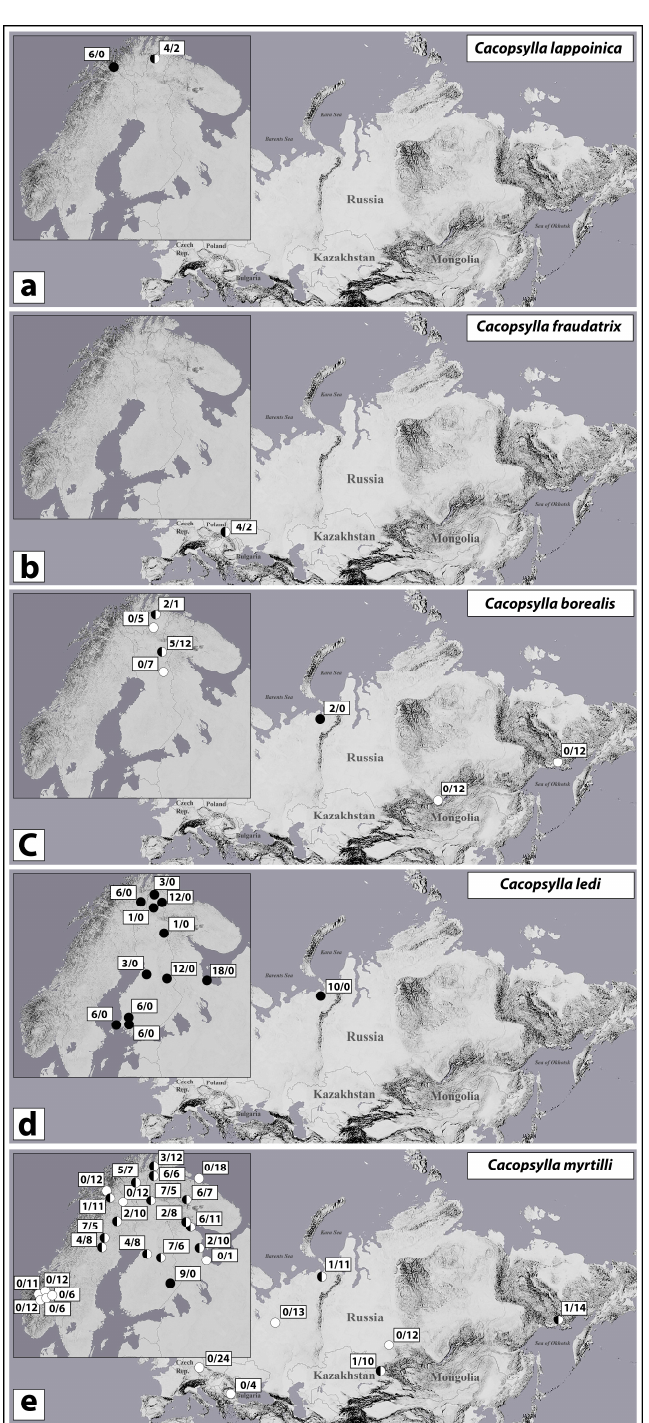
Figure 2. Distribution of Wolbachia infection in five Cacopsylla species ( a – e ). White circles indicate uninfected populations; black circles indicate completely infected populations; black-and-white circles indicate mixed populations comprising both infected and uninfected specimens. Numbers at circles indicate proportion of infected specimens (before slash) to uninfected specimens (after slash) in each population.